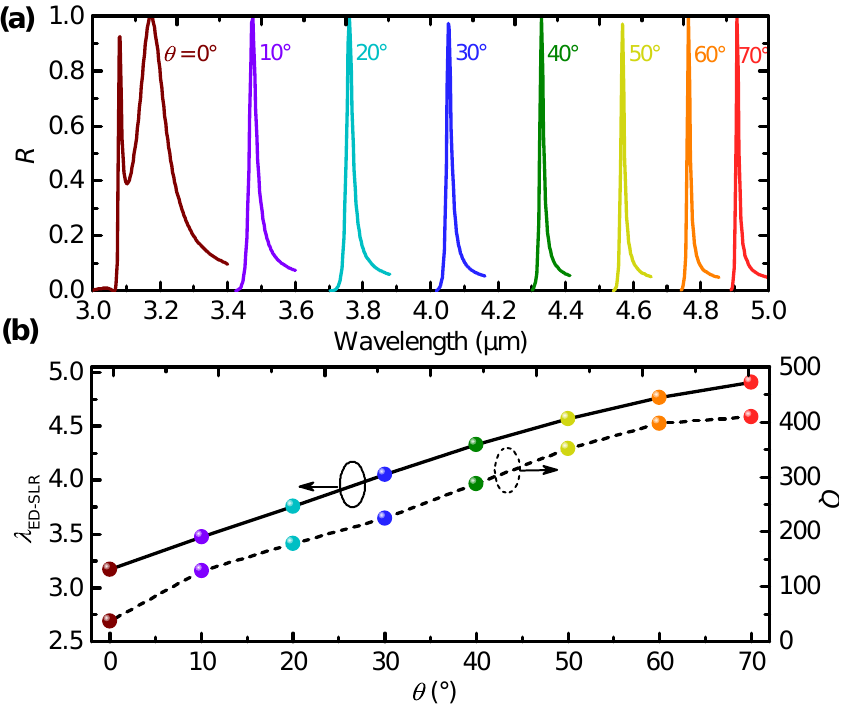
Figure 6. ( a ) Simulated reflectance spectra for different incidence angles. For clarity, the tails are not shown; ( b ) the resonance wavelength and the quality factor of the ED-SLR as a function of the incidence